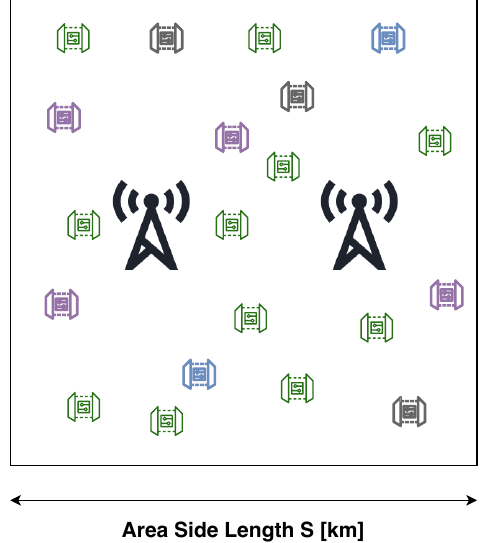
Figure 1. A scenario with two LoRaWAN gateways and four operators. All of the nodes generate packets with a rate λ i . Transmission attempts are done according to a Poisson process with packet size l being constant. Let T s be the time that is needed to transmit a packet of size l while using spreading factor s . LoRa supports SFs that range from 7 to 12. The latter represent a trade-off between coverage and data rate. For instance, SF7 yields the highest data rate, but it covers the shortest distance. The SFs are orthogonal meaning that packets transmitted during the same time frame with different SFs will be successfully received. LoRa utilizes forward error correction to detect and correct transmission errors with the coding rate set to 4/( C +4), where C ∈ {1,2,3,4}. Table 1 shows the variation of data rate, sensitivity, and SNR thresholds as a function of the SFs that are utilized in the 868 MHz band for C = 4. Table 1. LoRa in the 868 MHz band.